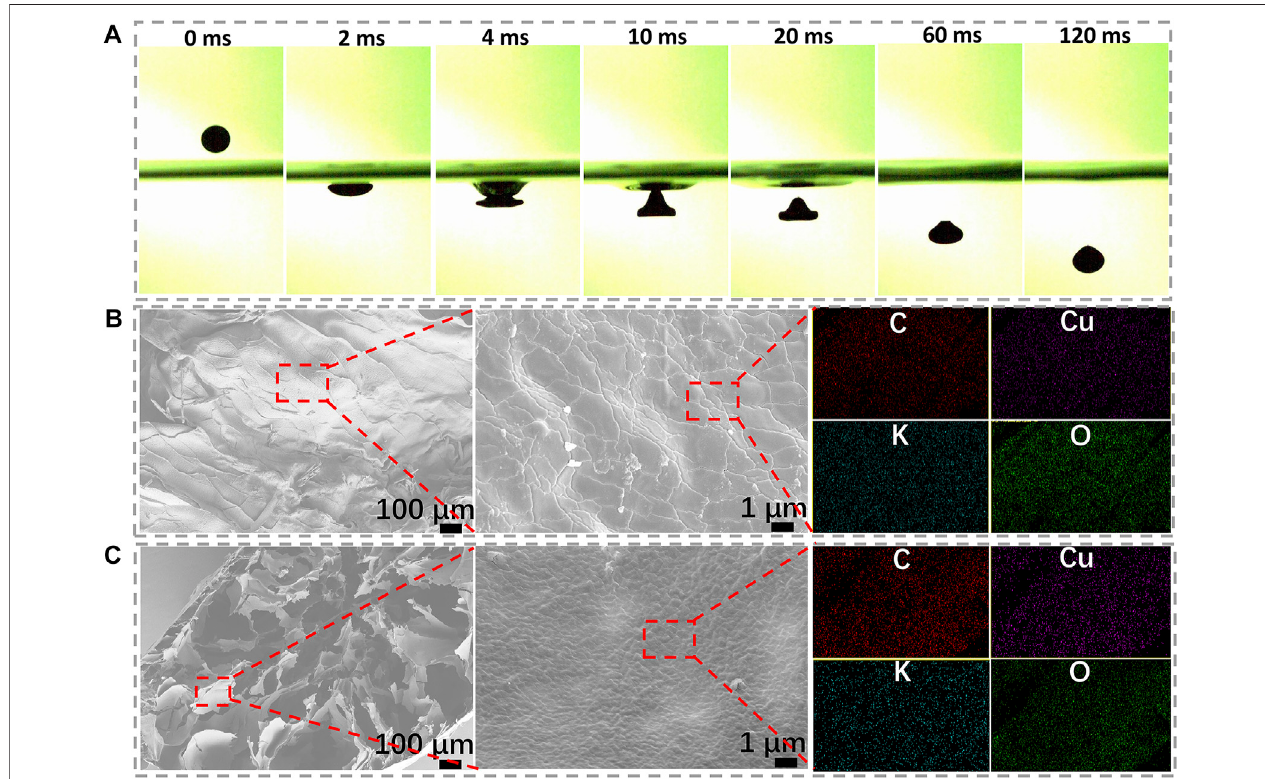
FIGURE 2 | (A) High-speed photography images of the hydrogel sphere; (B) Surface microstructure and EDS mapping of the hydrogel; (C) Cross-section images and EDS mapping of the hydrogel.